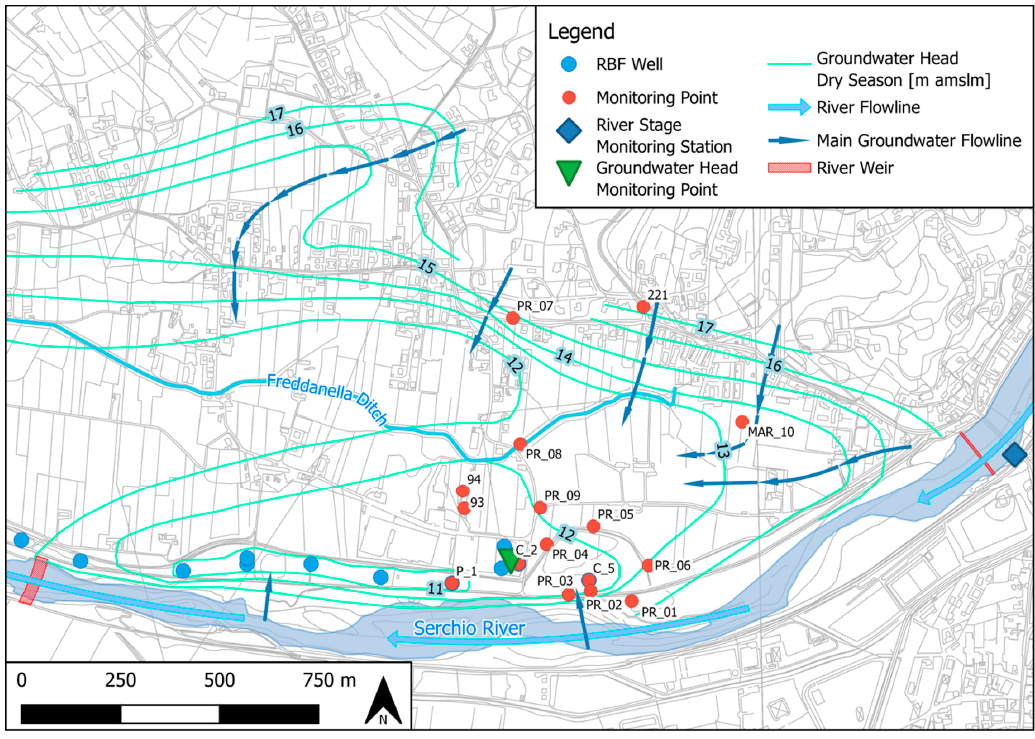
Figure 5. Monitoring network (groundwater head and hydrochemistry) in relation to the main groundwater flow directions. Piezometric head data from September 2003 (dry season; data from Studio Nolledi 2003). Hydrology 2020 , 7 , x FOR PEER REVIEW